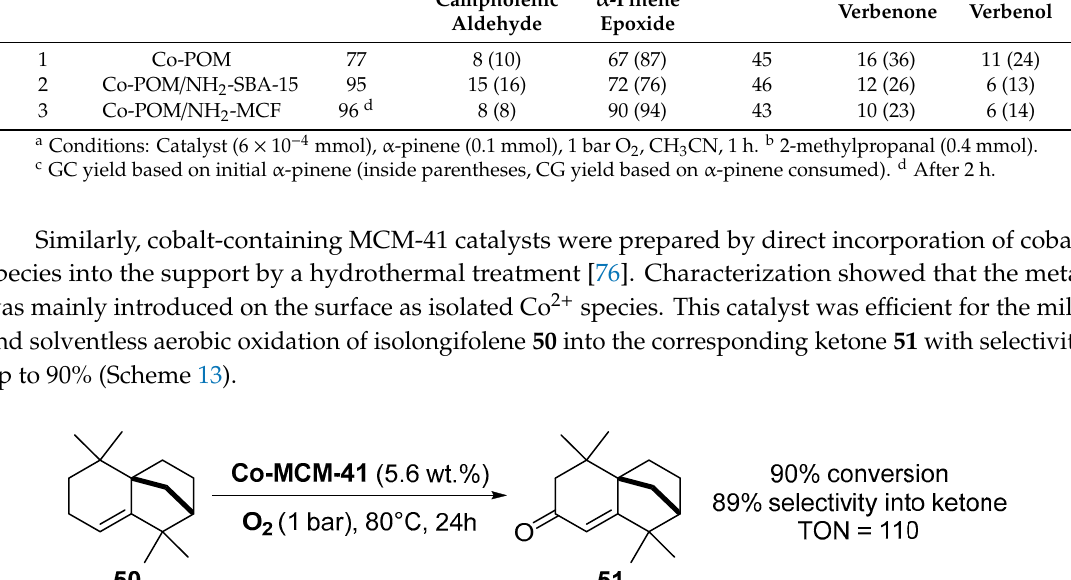
Table 22. Effect of 2-methylpropanal on the aerobic oxidation of α -pinene 1 with cobalt-substituted polyoxometalate on amino-modified supports a (adapted from reference [75]). defined as moles of the substrate converted/moles of metal (Co or Mn). With 2-Methylpropanal at 25 °C b